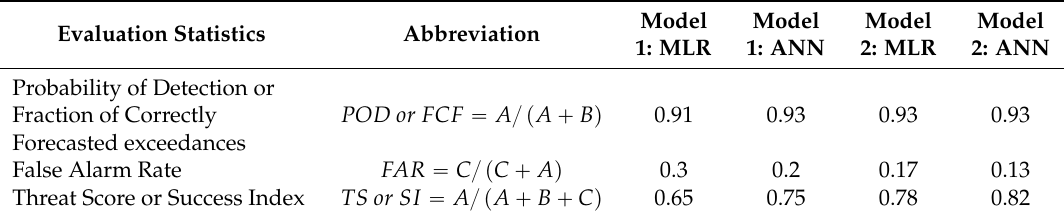
Table 2. Evaluation statistics for forecasting of high values (PM 10 > 75 µ g/m 3 ) using MLR and ANNs [66], reprinted by permission of the Air & Waste Management